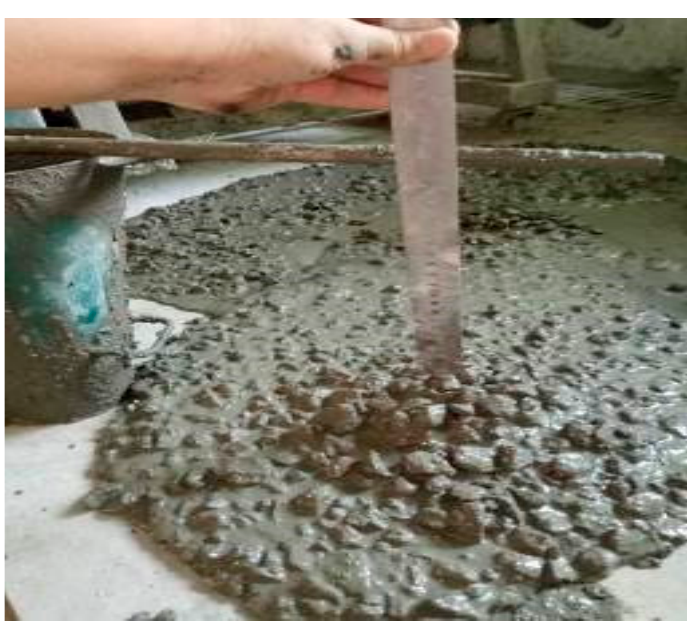
Figure 1. Slump test of the concrete.